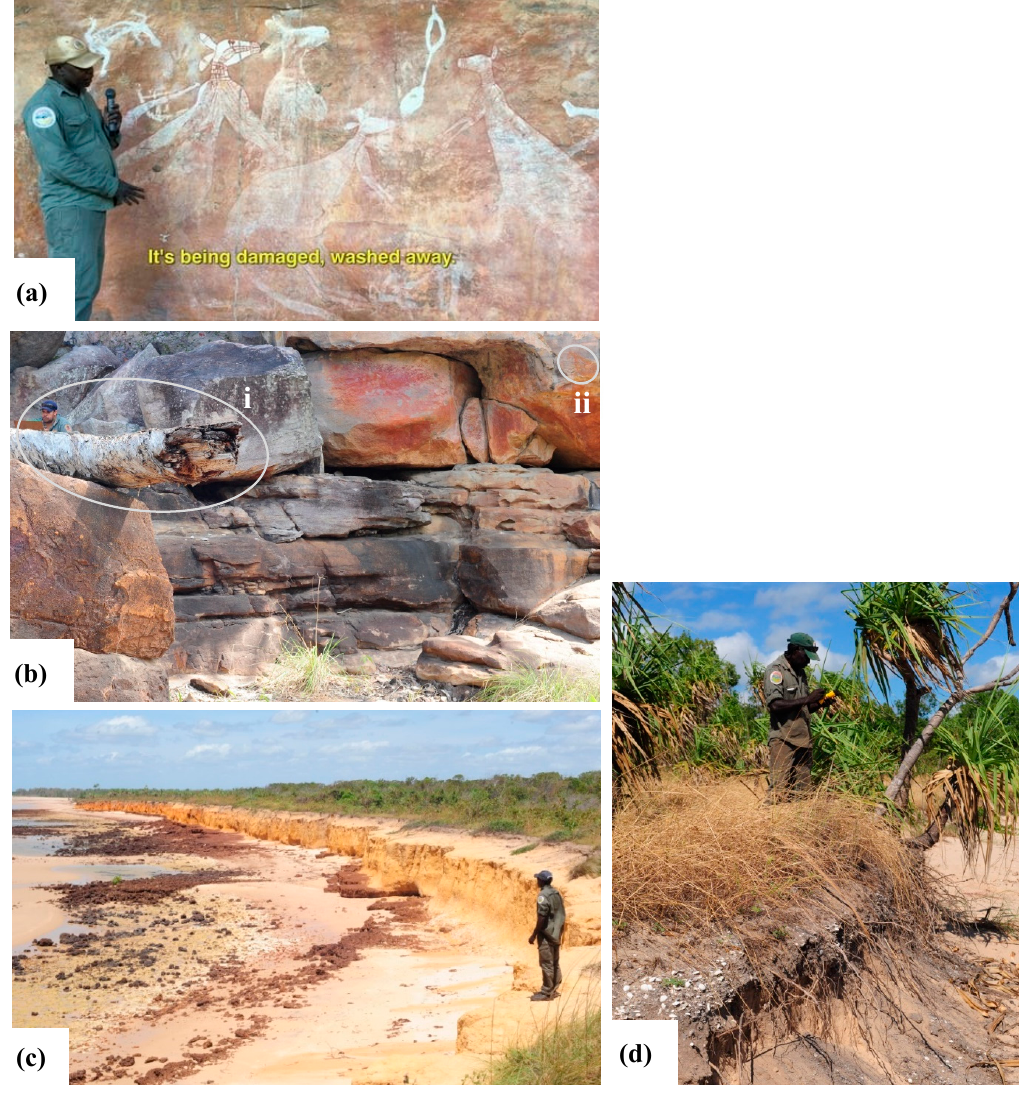
Figure 1. Assessing climate change threats to rock art and middens. ( a ) Djelk ranger Ivan Namarnyilk